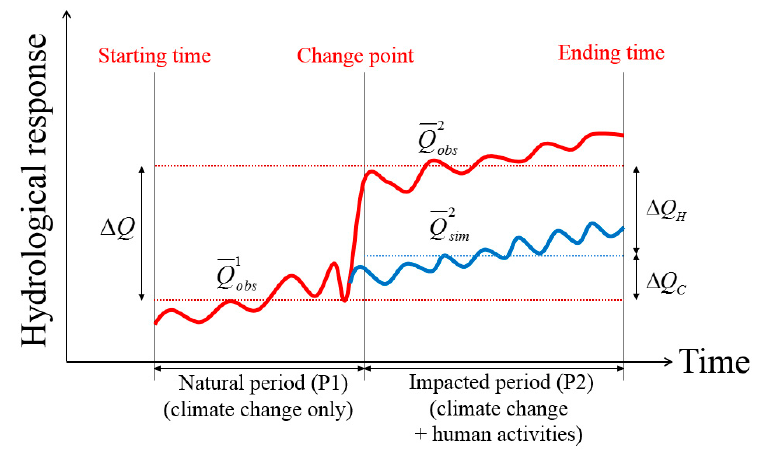
Figure 4. Schematic diagram to quantify relative impacts by two factors.